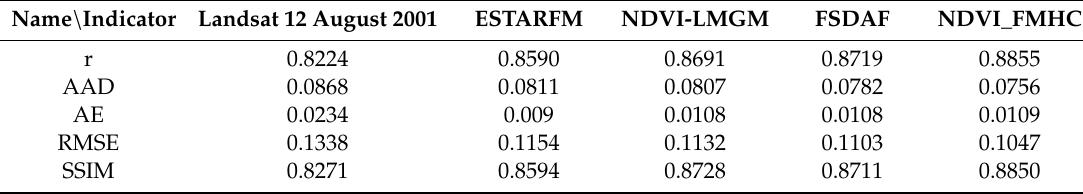
Figure 14. Visual comparison of inset map in urban area. ( a , b ). Original Landsat_NDVI inset map 1 November 2000 and 7 November 2002; ( c – f ). Predicted Landsat_NDVI inset map by ESTARFM, NDVI-LMGM, FSDAF, and NDVI_FMHC. Table 5. Accuracy comparison of four fusion methods in urban area.